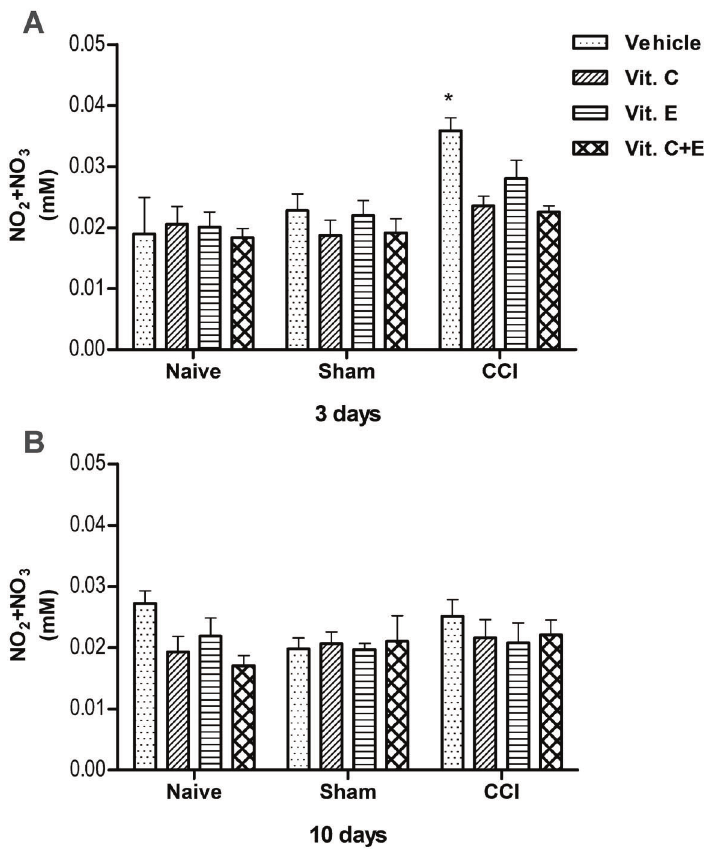
Figure 7. Nitric oxide metabolites (NO 2 + NO 3 ) in the spinal cord of rats treated with vit. C (30 mg (cid:1) kg – 1 (cid:1) day – 1 ), vit. E (15 mg (cid:1) kg – 1 (cid:1) day – 1 ), a combination of these vitamins (vits. C + E) in the same doses, or the vehicle alone (saline containing 1% Tween 80) administered intraper- itoneally for 3 ( A ) and 10 ( B ) days after chronic constriction injury (CCI). Data are reported as means ± SE (n=6/group). *P o 0.05 compared to naive and sham rats and vit. C and vits. C + E-treated CCI rats over the same experimental period (two-way ANOVA followed by Tukey post hoc